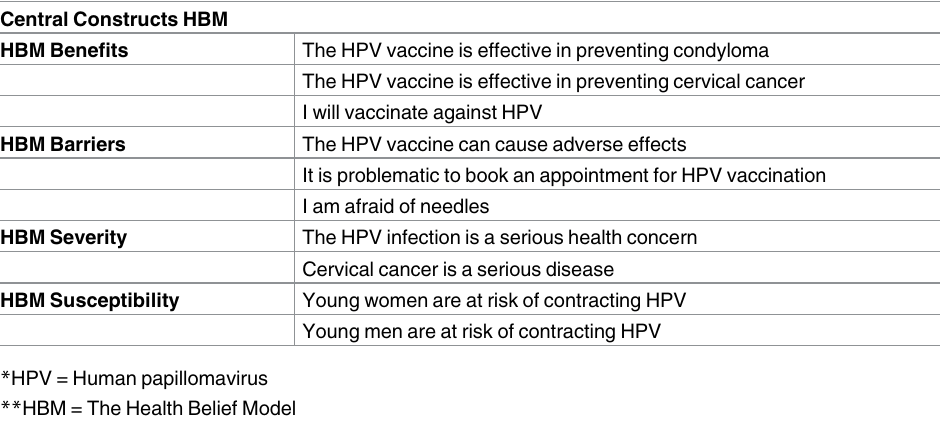
Table 1. Beliefs about HPV * and HPV vaccine–questions based on HBM **